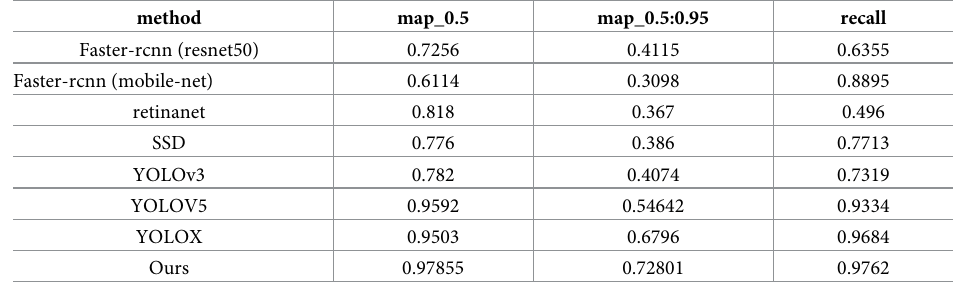
Table 2. Comparison experiments between the proposed method and each comparison method on the MSD data